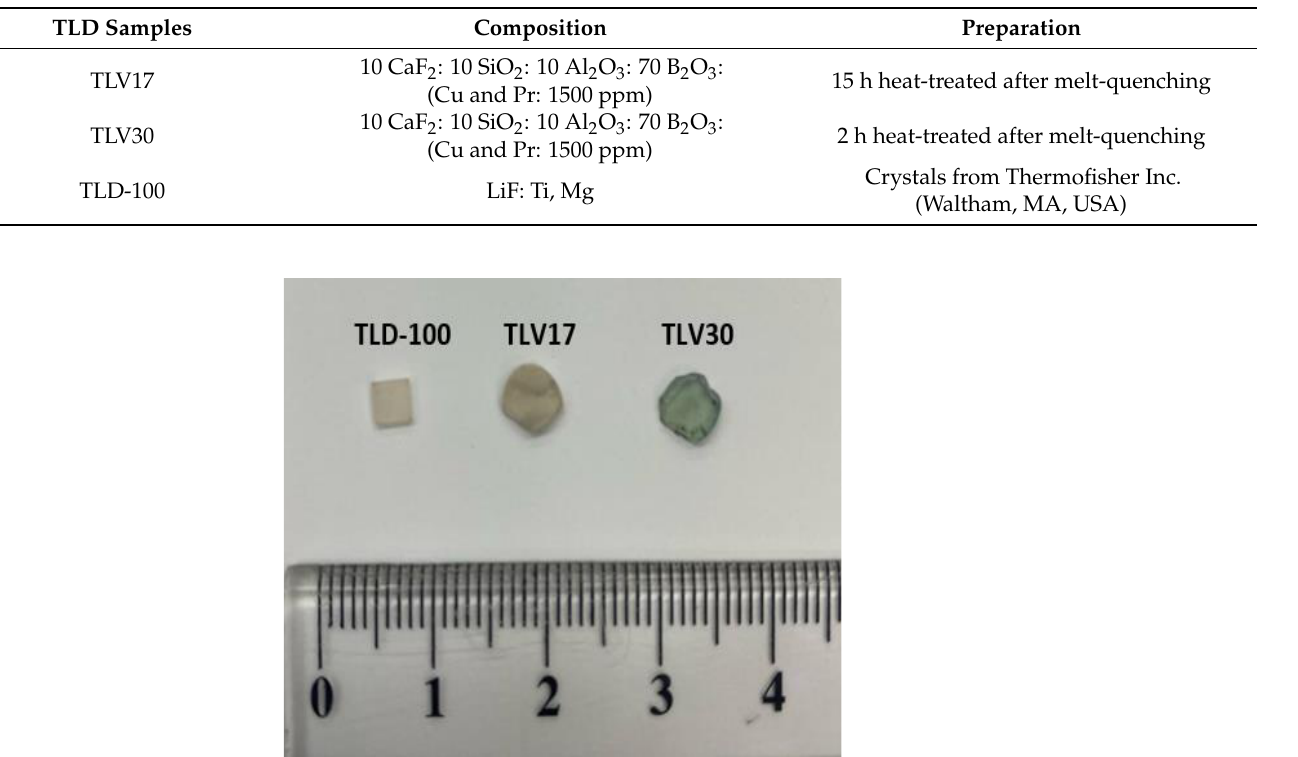
Table 1. Samples, compositions and preparation methods of the TL dosimeters used in the present study .